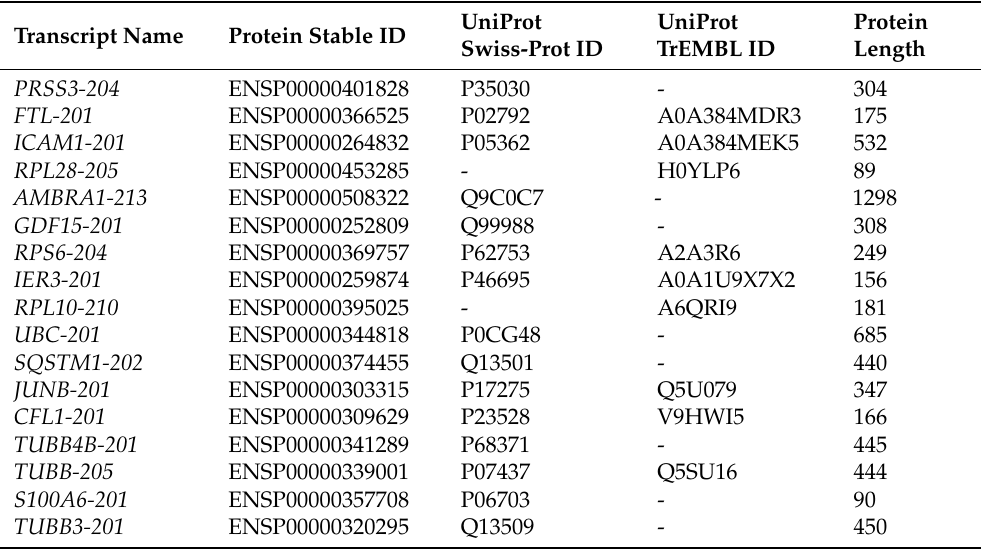
Table 6. Protein products of identified mRNA isoforms associated with the development of resistance to docetaxel in the PC3 cells. The annotation was obtained from the UniProt database.